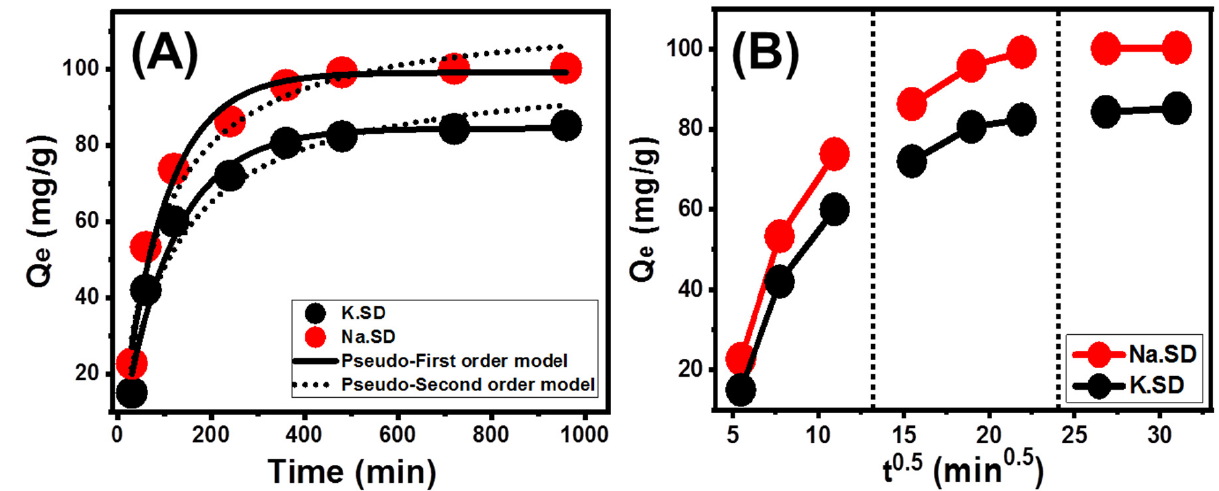
Figure 5. Effect of the duration time on the sequestration of PO 43 − and its intraparticle diffusion properties ( A ), and fitting of the PO 43 − sequestration results with the kinetic models ( B ) (100 mg L − 1 phosphate concentration, 20 °C temperature, 0.1 g L − 1 dosage, pH 6).